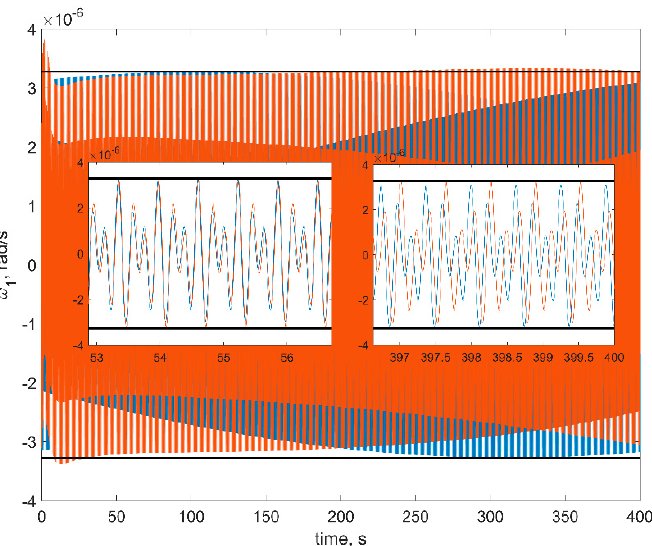
Figure 6. Evolution of ω 1 (red is numerical solution, blue is approximate solution, horizontal lines are the estimations).